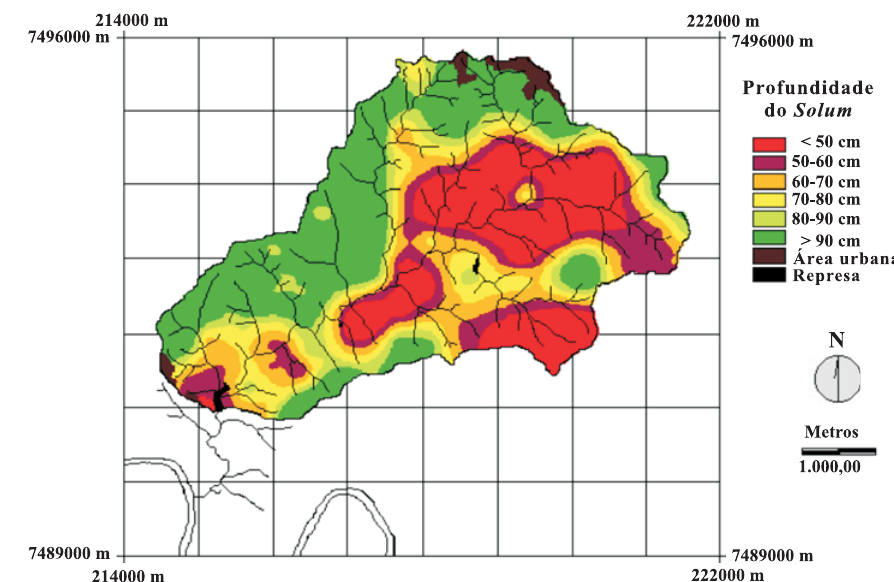
Figura 2. Mapa da profundidade do solum (soma das espessuras dos horizontes A + B) na área de estudo.